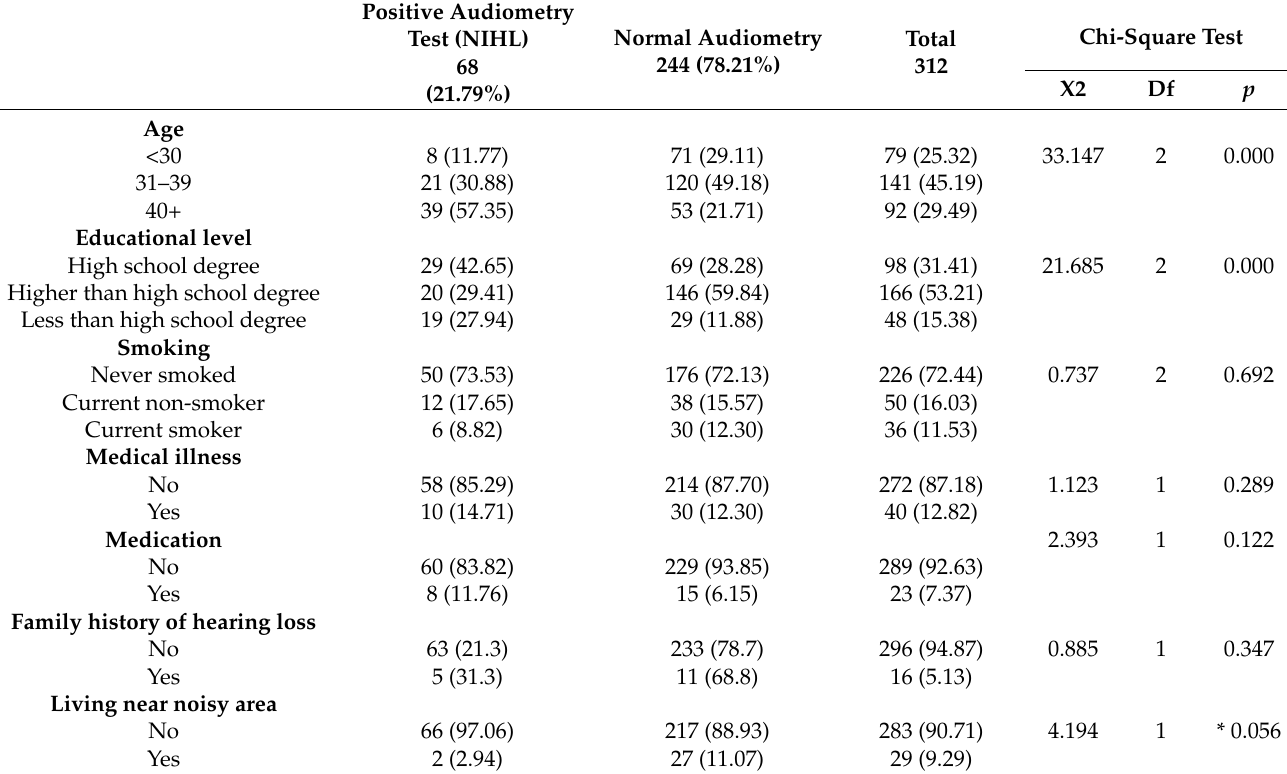
Table 4. Distribution of individual characteristics in relation to audiometry test